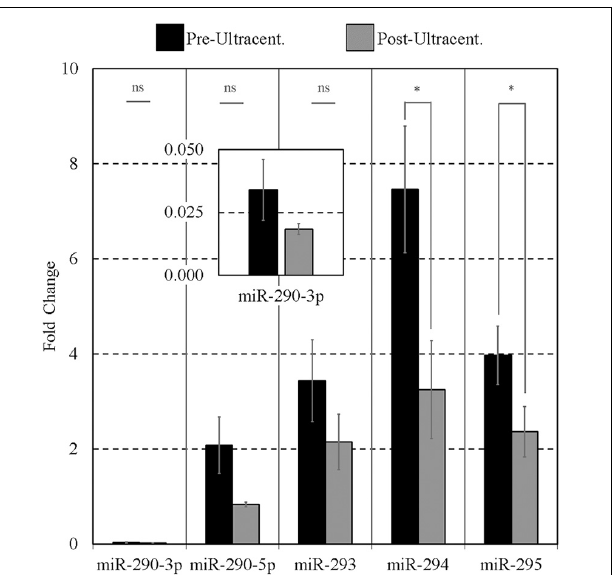
FIGURE 5 | Impact of ultracentrifugation on the extracellular miR-290 sequences suspended within the conditioned culture media. Ultracentrifugation was performed on 15 µ L of each 20- µ L microdroplet at 100,000 × g for 70 min according to Théry et al. (2006) to evaluate the degree of settling of the sequences. Each 20- µ L microdroplet was conditioned for 17 h with 10 morulae or early blastocysts from 99 to 116 h post-hCG. Each data point represents 2.5 µ L of conditioned culture media. Blank media was cultured in tandem and used as a negative control. n = 3, error bars = SEM. ∗ p <